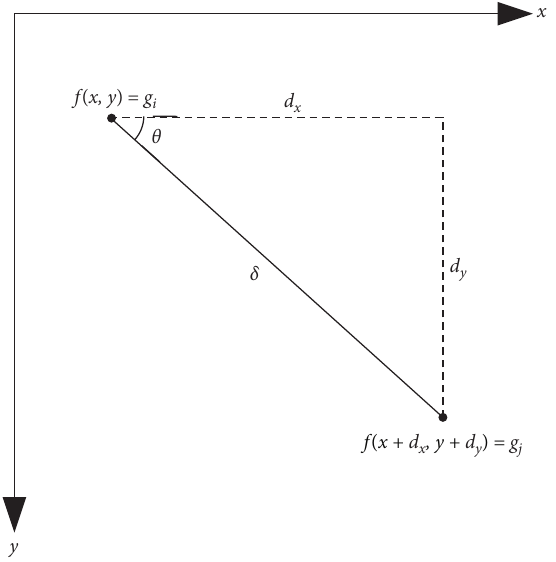
Figure 7: The relationship of two pixels.